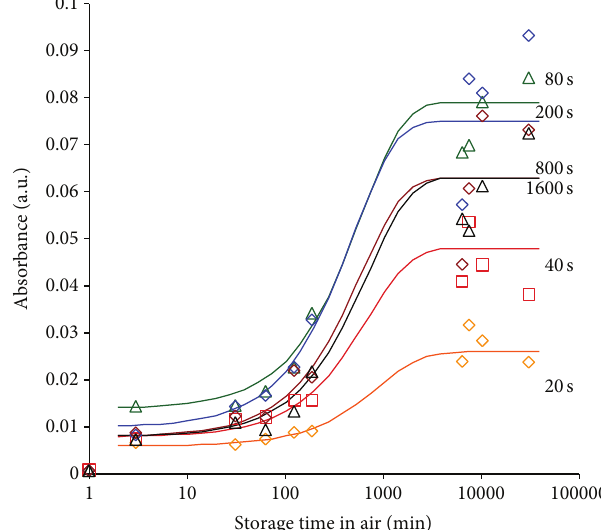
F 7: e ATR-FTIR absorbance intensity due to the 1712cm stretch vibrations of UHMWPE as a function of storage time aer PIII treatment for various times of PIII treatment.